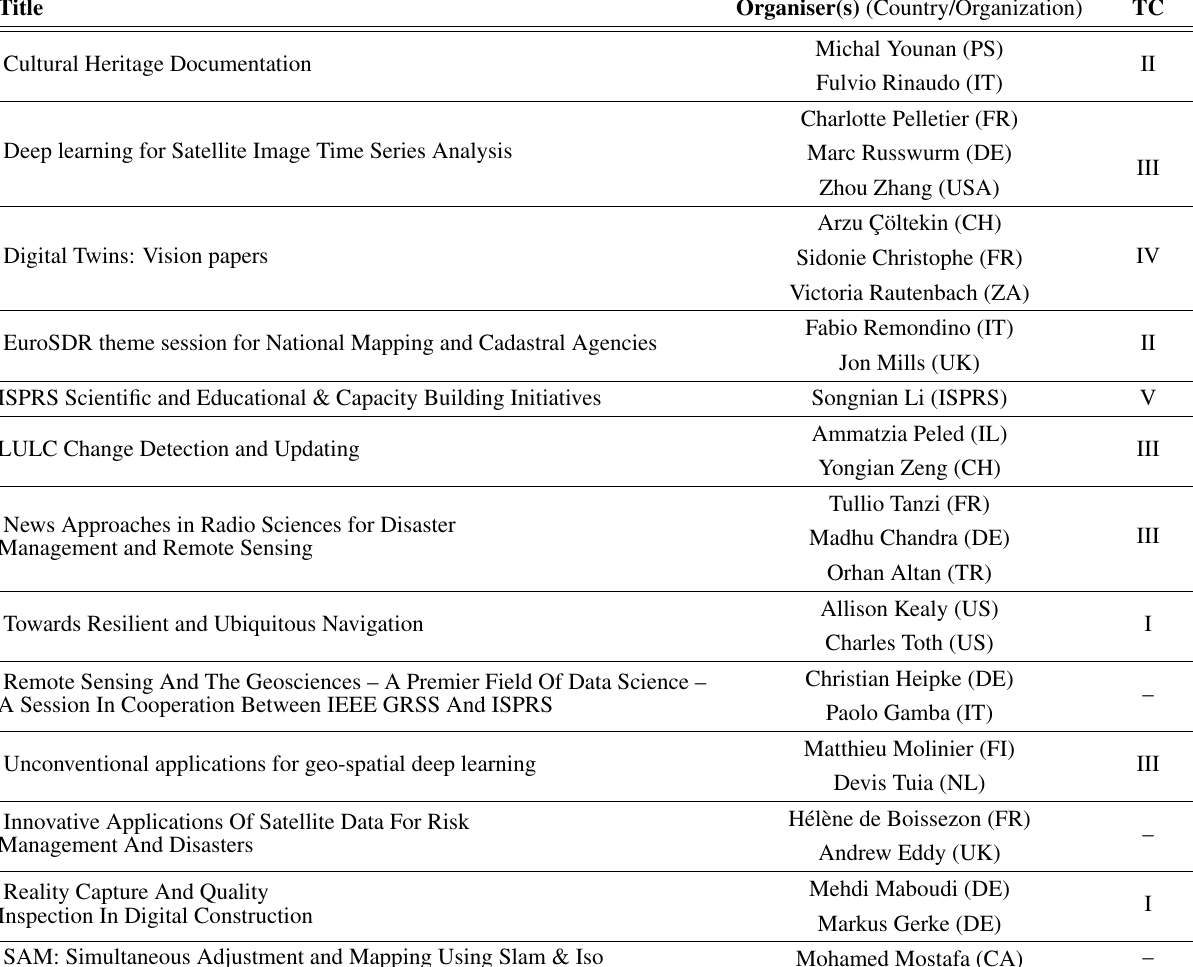
Table 1. Thematic Sessions of the 2022 edition of the ISPRS Congress. ”–” means that no papers were published in the